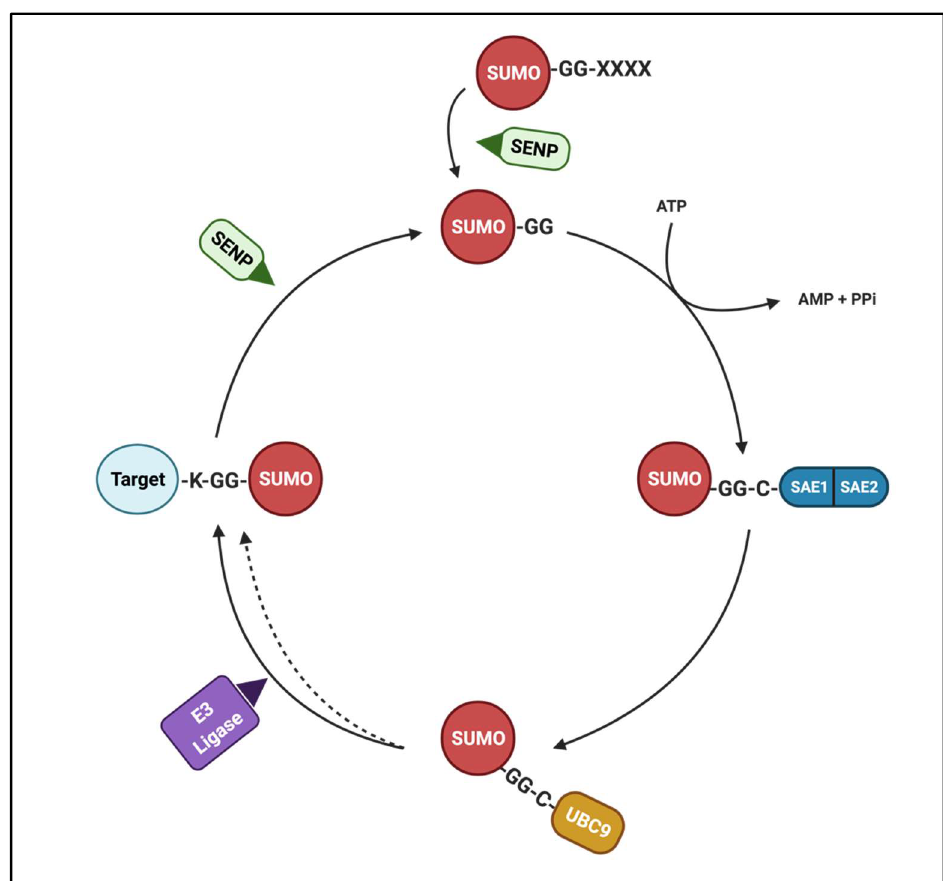
Figure 1. The biochemistry of the SUMOylation pathway. SUMO precursor proteins undergo a maturation process mediated by SENPs that exposes the GG motif. Next, ATP dependent activation of SAE1/SAE2 (E1 SUMO activating enzyme) transfers the mature SUMO to Ubc9 (E2 SUMO conjugating enzyme). Ubc9 transfers SUMO to an acceptor lysine moiety in the target protein with (and sometimes without) the involvement of a E3 SUMO ligase enzyme. DeSUMOylation of SUMO-conjugated proteins is facilitated by